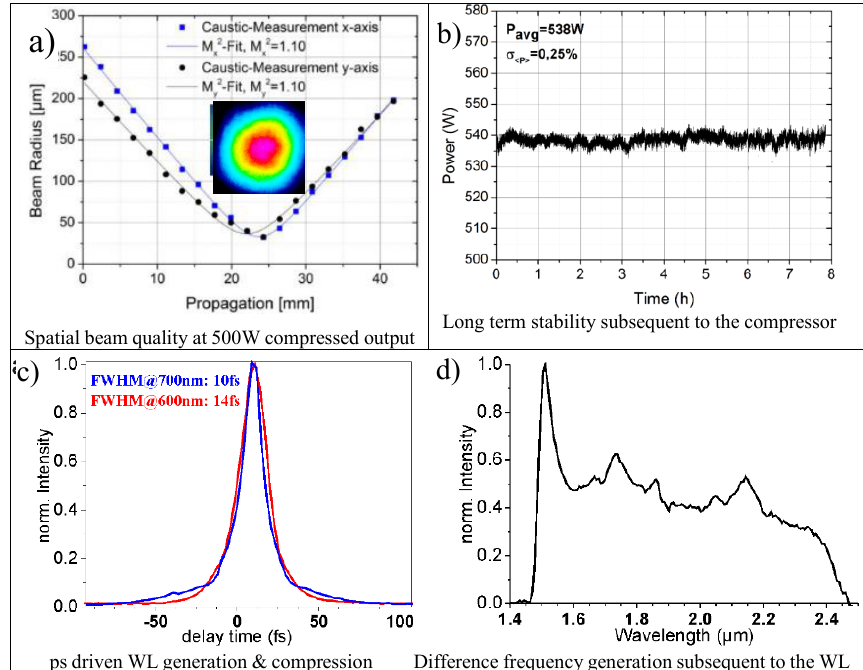
Fig. 2: Characterization of the 500W output (a &b) and of the white light driven with 3µJ, ps pulses in c). IR seed pulses are derived through DFG, generated by selecting different spectral components of the white light